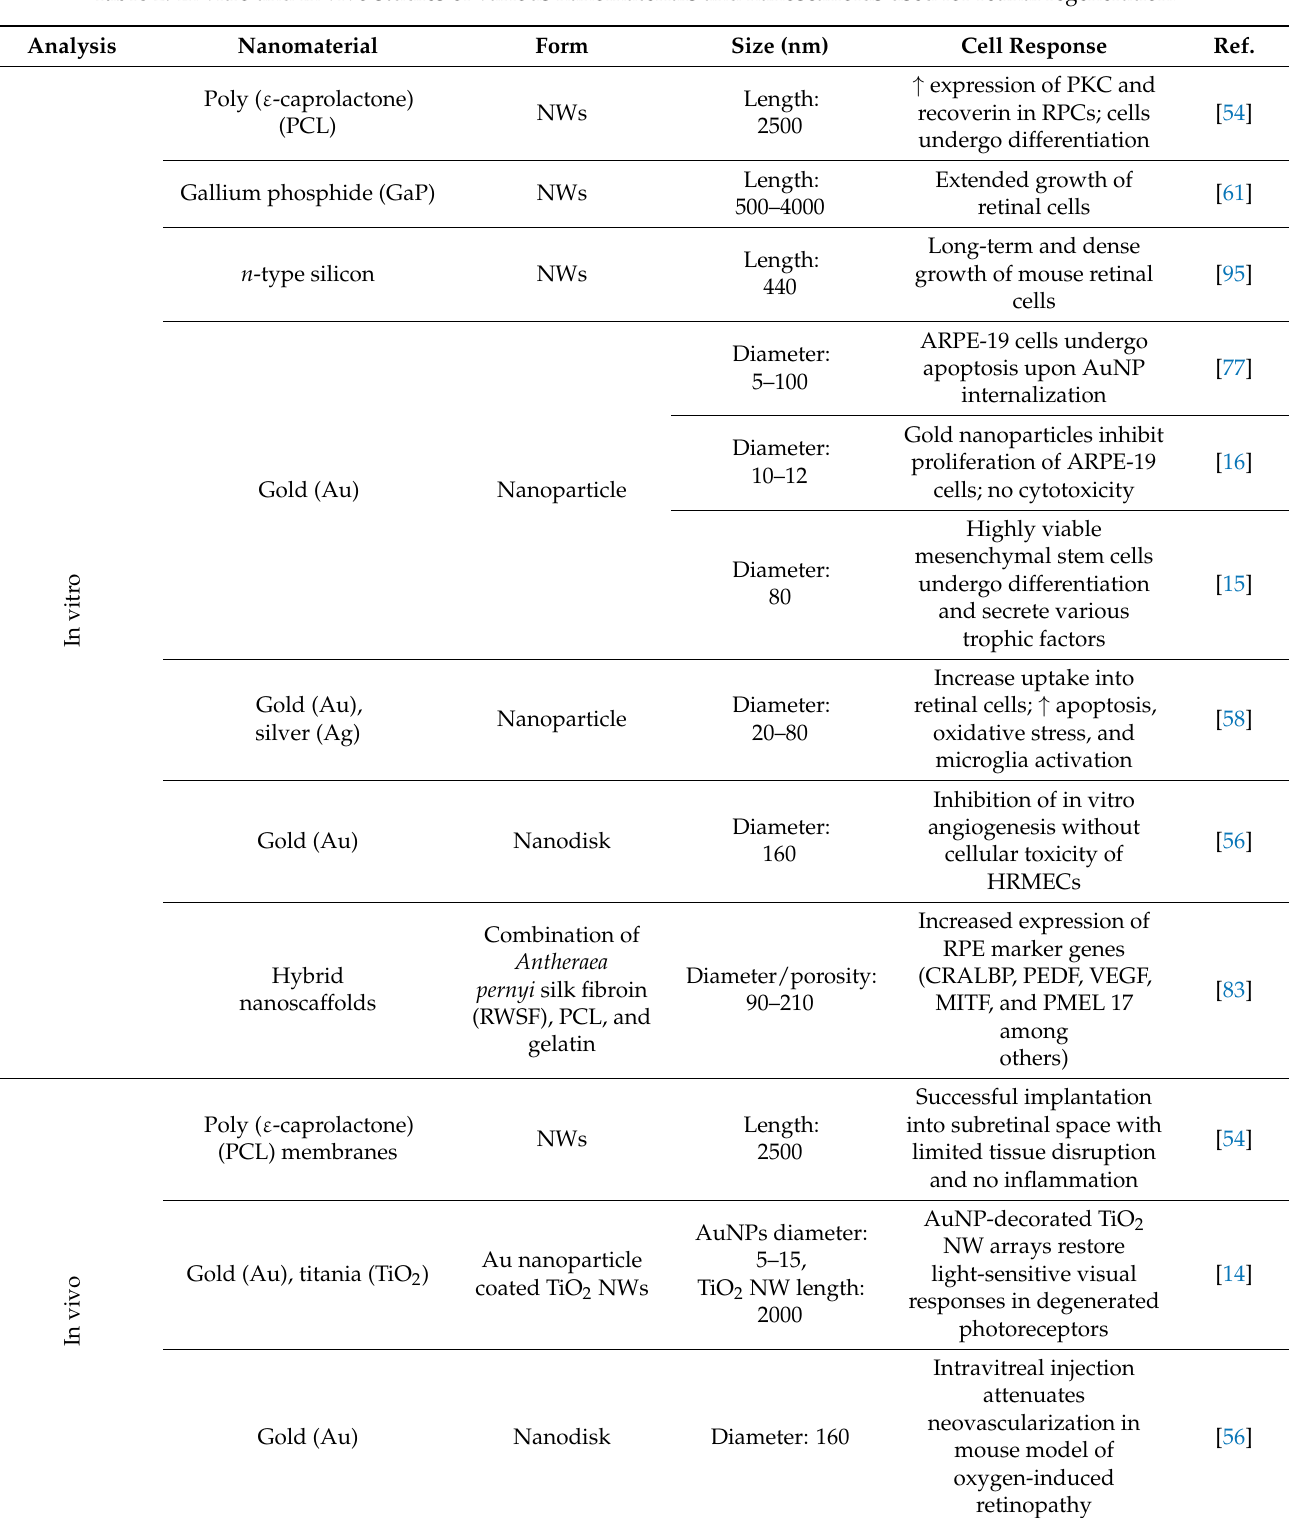
Table 2. In vitro and in vivo studies of various nanomaterials and nanoscaffolds used for retinal regeneration.